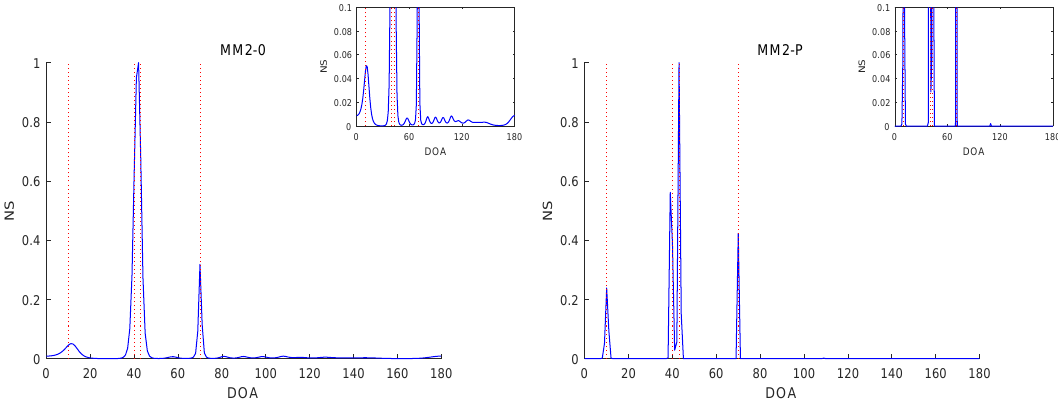
Figure 7. NSs of Experiment 2 with n = 100, SNR = 0 dB and ∆ ξ = 15 ◦ .